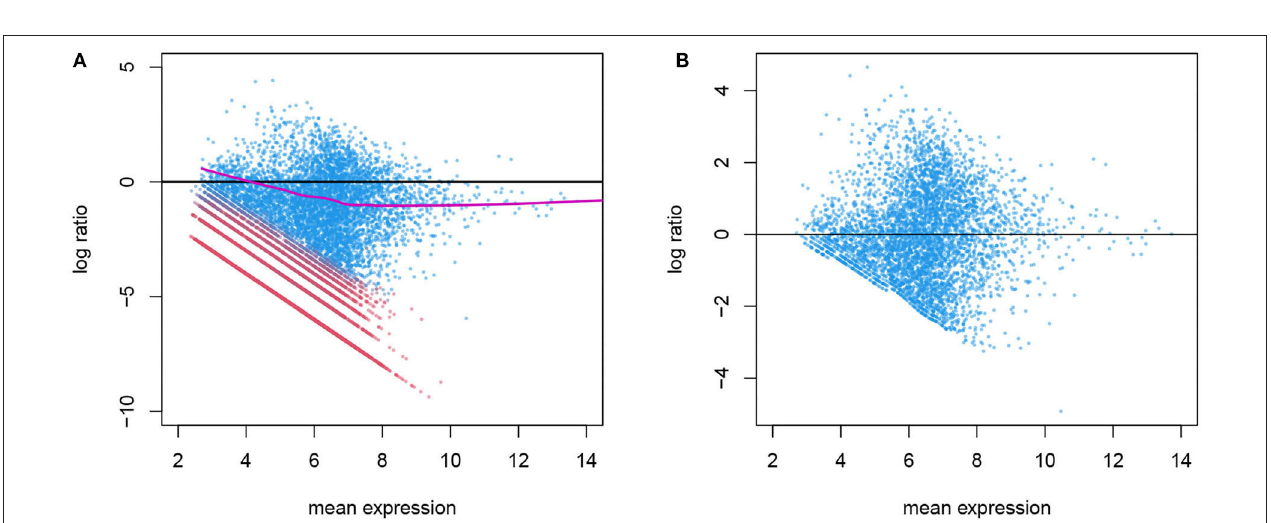
FIGURE 2 | Gene counts are positively correlated with library size when the gene is expressed (blue) but appear to have little correlation with library size when they are in the background phase (red). (A) Data from T2D study. (B) Data from hESC study.